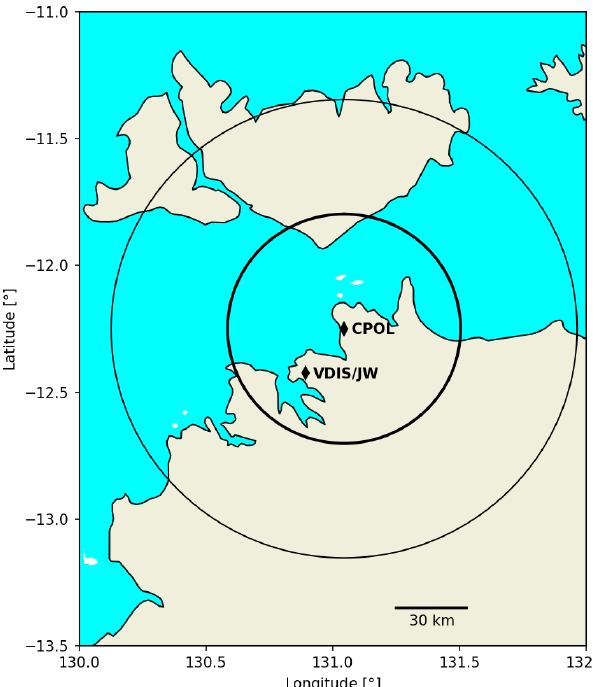
Figure 1. Map of CPOL and JW/VDIS locations. Range rings rep- resent distances 50 and 100km from the